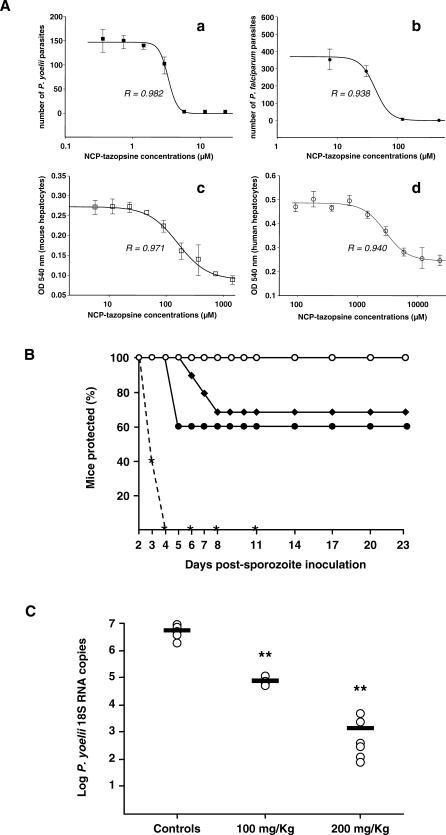
Inhibitory Activity of NCP-Tazopsine on Plasmodium Hepatic Stages in vitro and Protective Activity of Tazopsine and NCP-Tazopsine for P. yoelii Infections in vivo(A) Representative curve of the dose-dependent inhibition of NCP-tazopsine (the number of parasite forms in test wells divided by the number of parasites in control wells) for (graph a) P. yoelii (filled squares [], average number in control wells = 152), and (graph b) P. falciparum (filled circles [•], average number in control wells = 384). Toxicity is presented for (graph c) mouse (open squares [□]) or (graph d) human (open circle [○]) primary hepatocytes. Results are means ± standard deviation within triplicates of one experiment.(B) Proportion of mice that failed to acquire a blood-stage infection following sporozoite challenge through treatment with tazopsine (filled diamonds [♦], 100 mg/kg), NCP-tazopsine (filled circles [•], 100 mg/kg, and open circles [○], 200 mg/kg), distilled water or 10% Tween in distilled water (asterisks [*] indicate control groups).(C) Dose-dependent reduction of hepatic parasite load by NCP-tazopsine following sporozoite challenge. Bar represents the average value. Significance was calculated in one-way ANOVA analysis for the whole dataset (p = 0.0012), coupled to a Tukey HSD test: double asterisks (**) indicate p < 0.01.